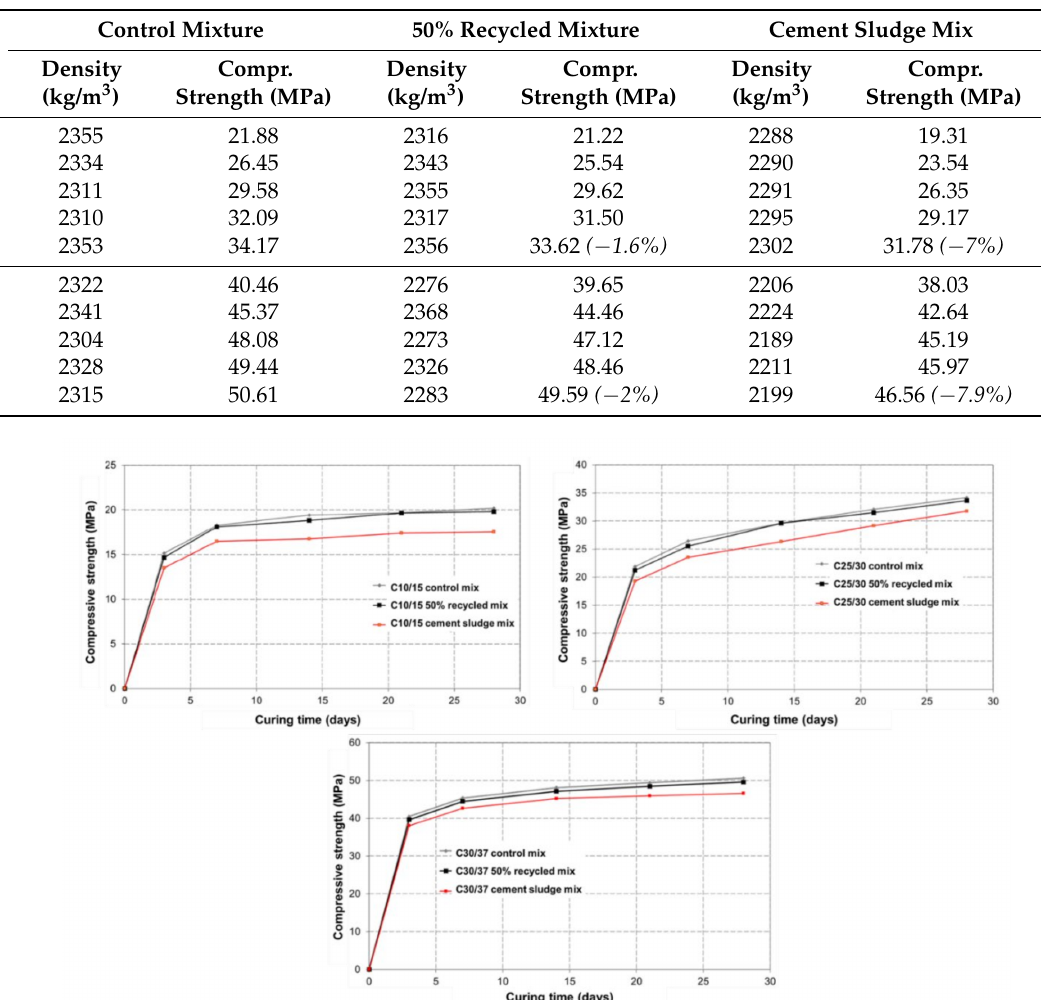
Figure 6. Compressive strength of concretes made with recycled and natural